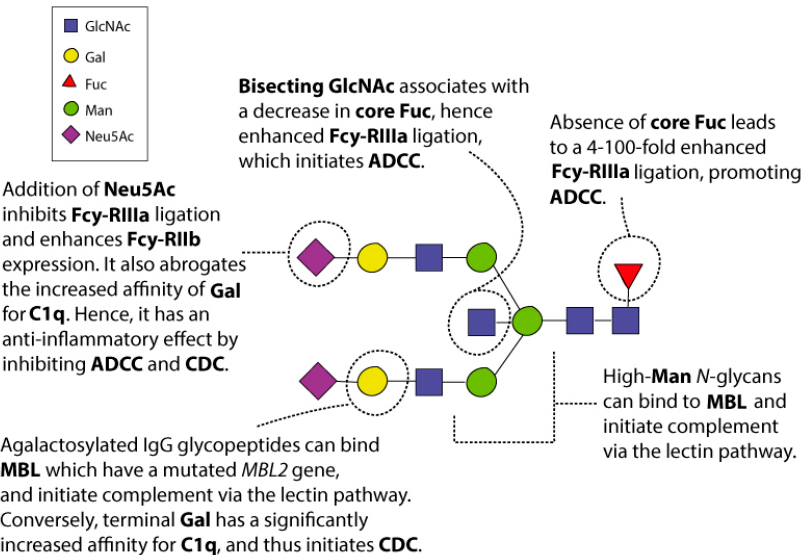
Figure 3. A picture summary of altered IgG glycosylation and its downstream effects. GlcNAc— N -